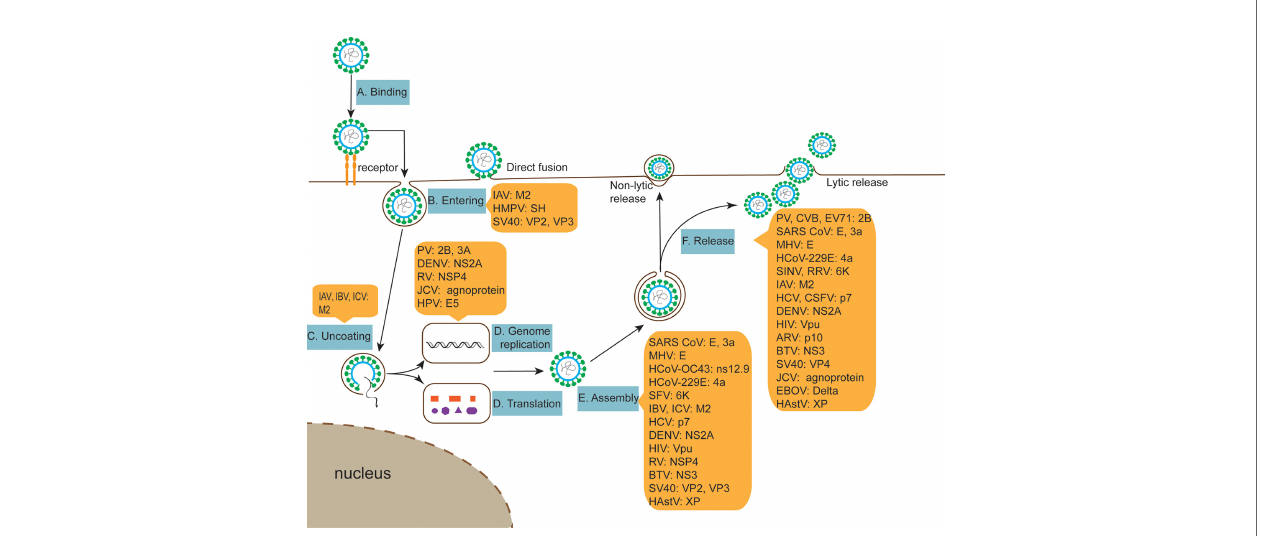
FIGURE 2 | The role of viroporins in the viral life cycle. (A, B) Viroporins facilitate viral penetration of host plasma membrane into cells. (C) Viroporins trigger conformational changes in the virus, releasing the genome. (D) Viroporins-mediated viral replication. (E) Viroporins facilitate the assembly of new viral nucleic acids with protein capsids. (F) Viroporins promote virus release from host cells by budding or lysis.